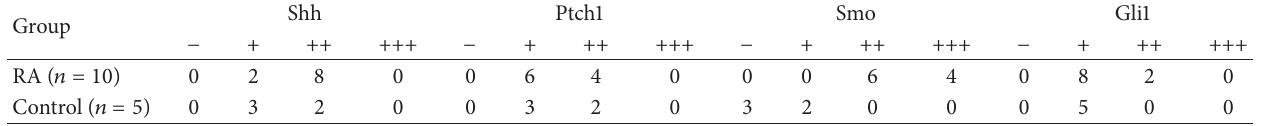
Table 1: Semi-quantitative analysis of Shh, Ptch1, Smo and Gli1 protein expression. Group